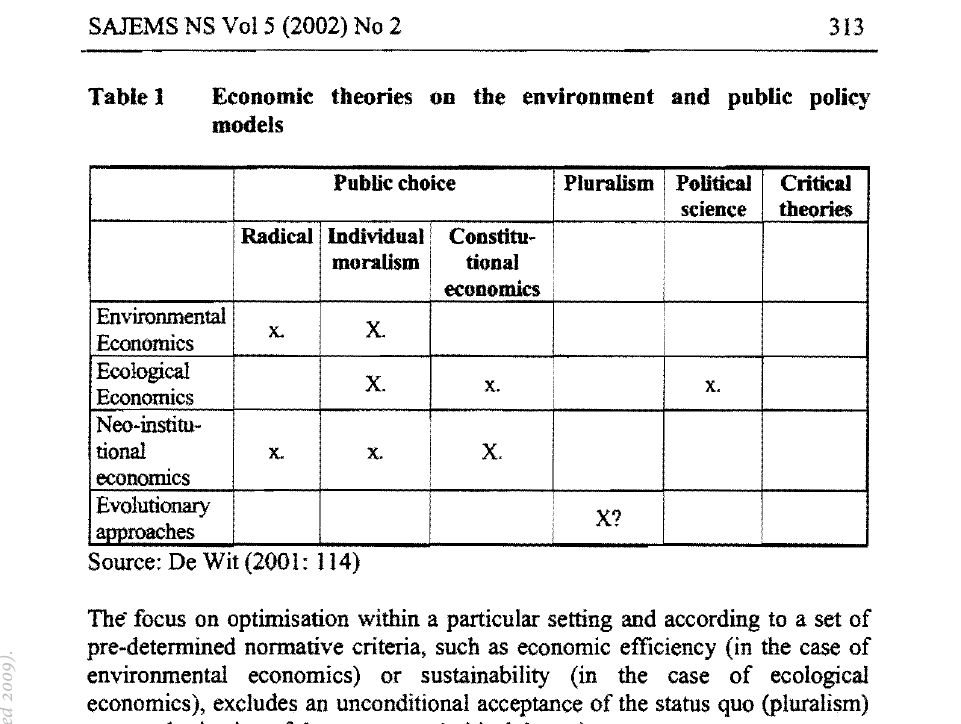
Economic theories on the environment and public